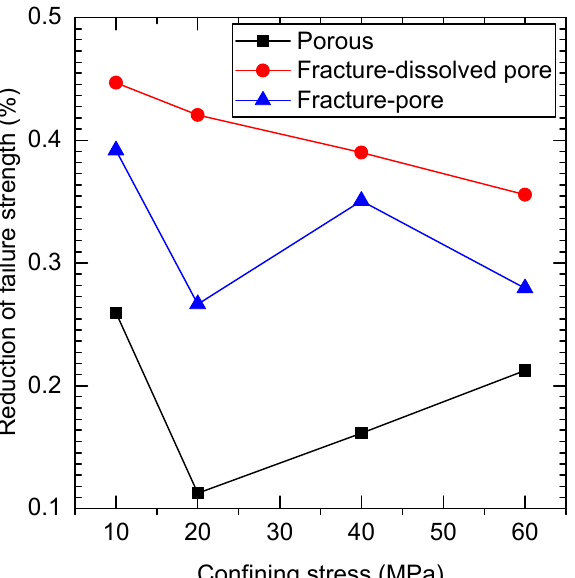
Figure 4. Effect of acid etching on the failure strength of rock samples with different reservoir elastic modulus reduction of the other two types of rock samples is relatively small, as space: ( a ) Porous, ( b ) Fracture-dissolved pore, ( c ) Fracture-pore. illustrated in Figure 7.